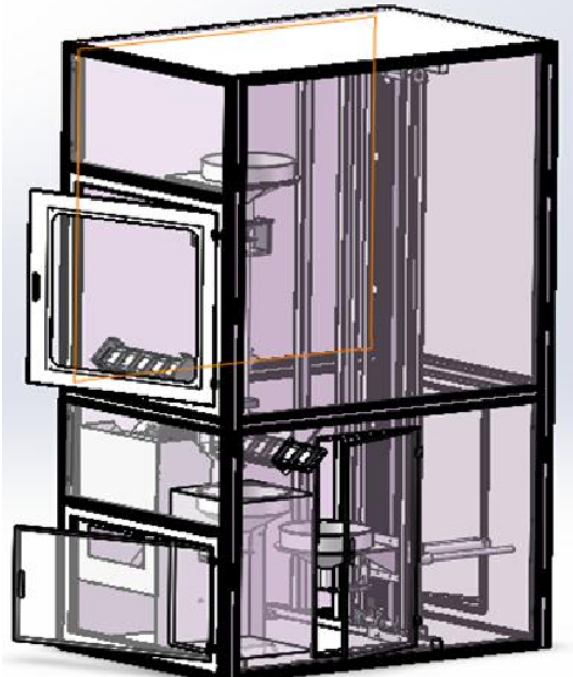
Fig. 4. Wear resistance testing